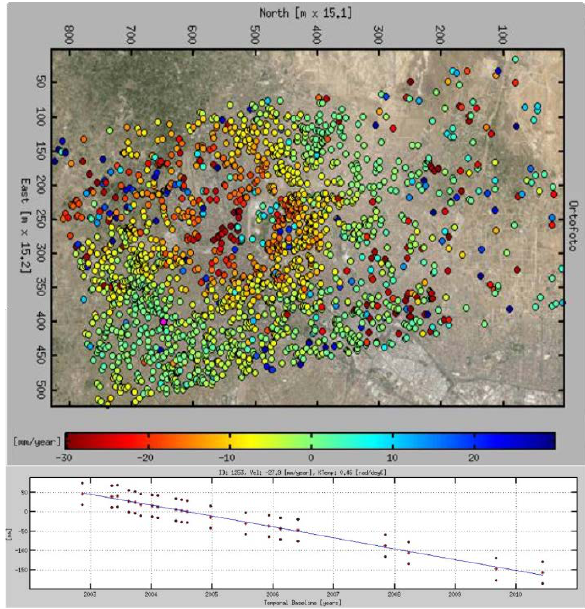
Figure 3. SarProz PS InSAR results for track 343 (Konya City Center - Karatay